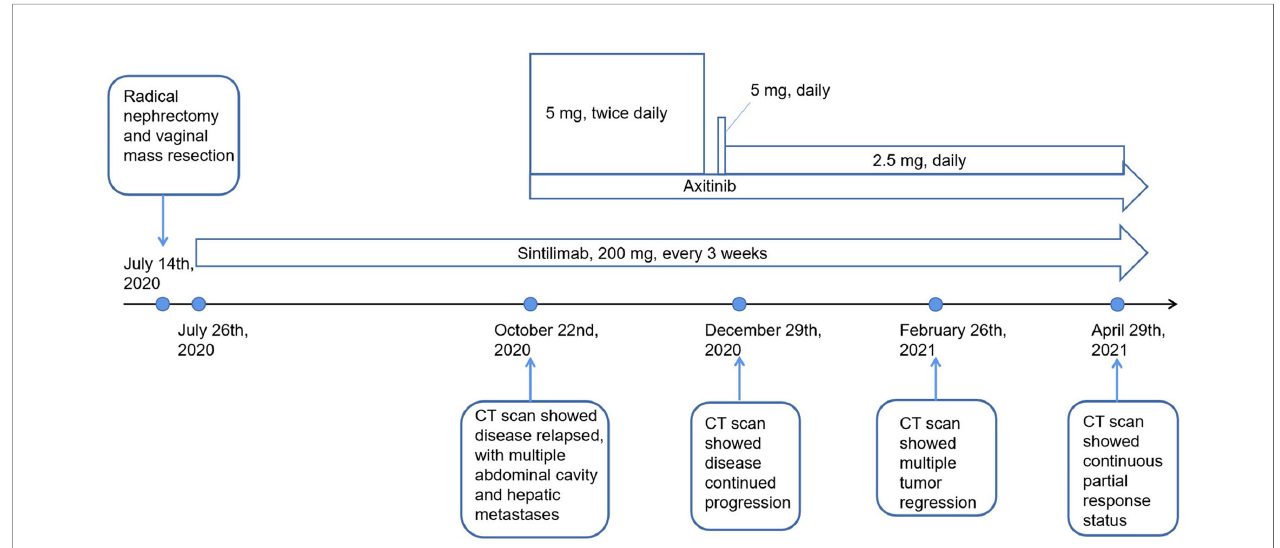
FIGURE 1 | Flow chart of patient ’ s main management